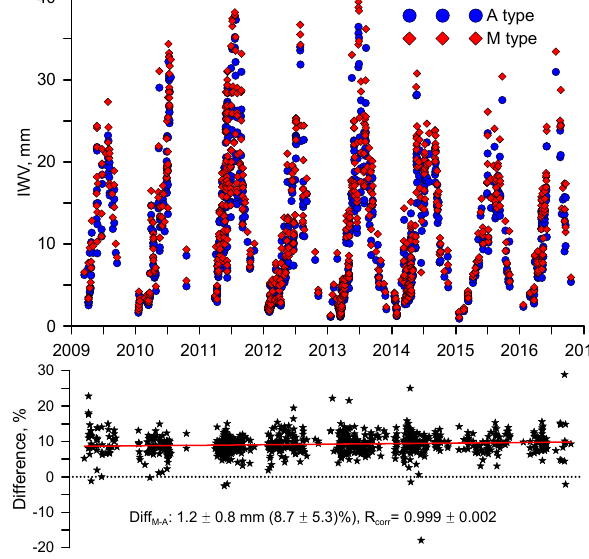
Figure 4. Time series of IWV measurements (above) using the FTIR method: the A type (blue circles) and M type (red diamonds) and their relative difference (below). Red line indicates a time de- pendence of differences approximated by a linear regression